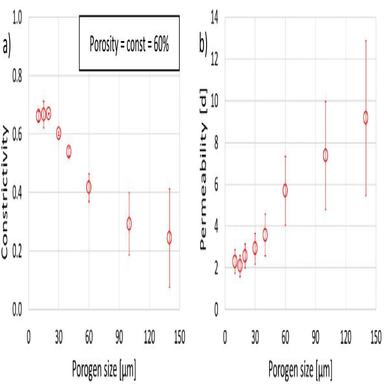
Constrictivity a), and permeability b) results for studied samples with constant porosity. Error bars indicate ± standard deviation.